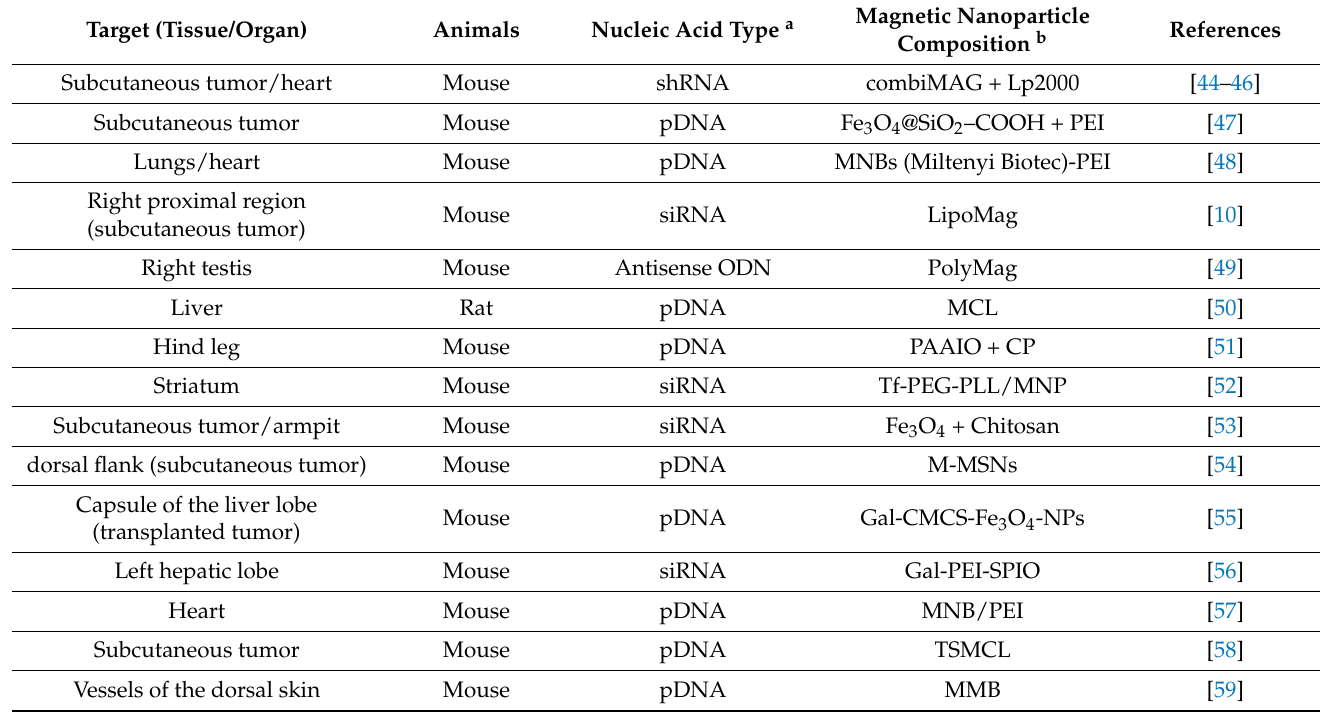
Table 1. Typical targets, nucleic acid types, magnetic nanoparticle compositions used in published research on magnetofec- tion in different animals after systemic injections of magnetic